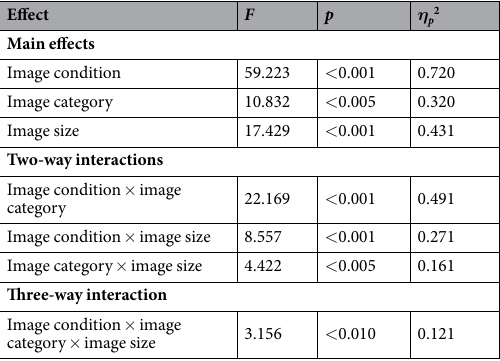
Table 7. Results of the 2 × 3 × 5 (image condition × image category × image size) ANOVA for a number of fixated image